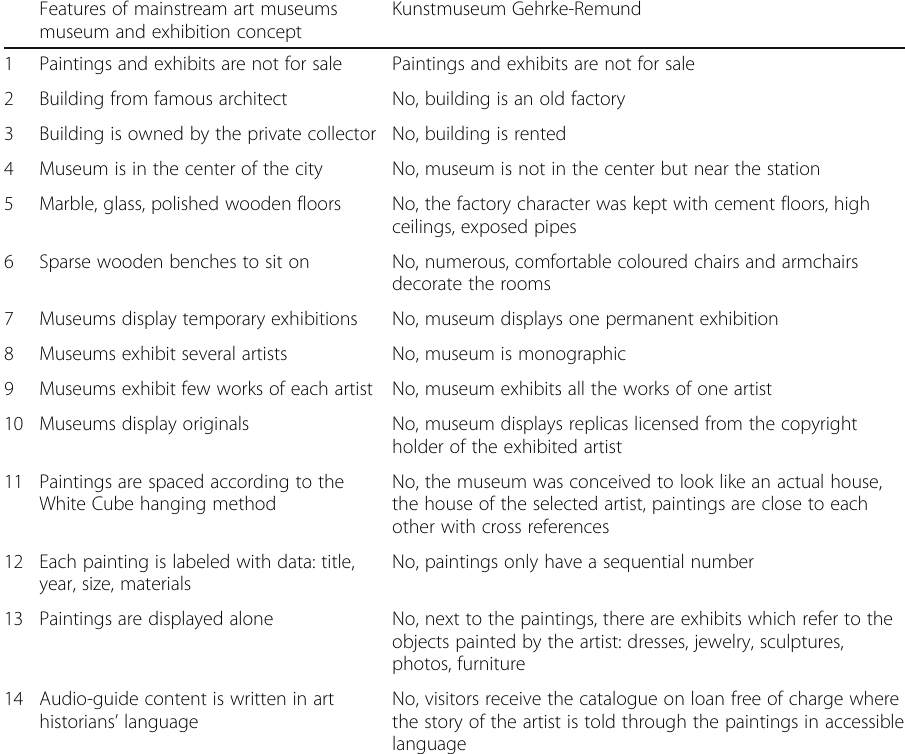
Table 1 Museum and exhibition concept: comparison of features between mainstream art museums and the Kunstmuseum Gehrke-Remund. © 2008 Kunstmuseum Gehrke-Remund Features of mainstream art museums museum and exhibition